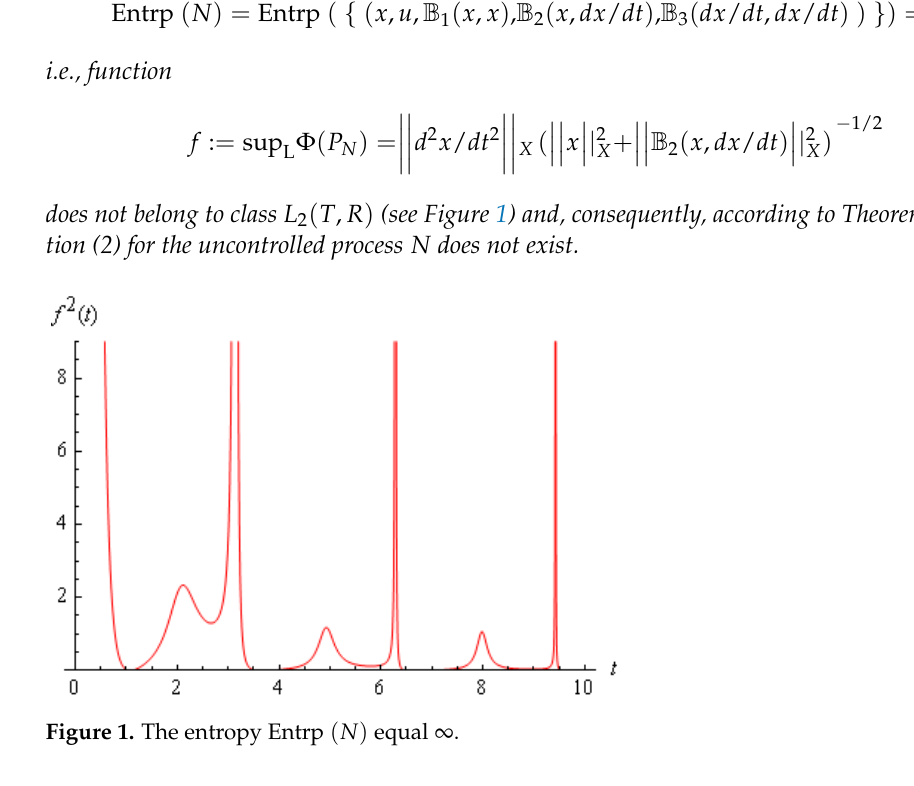
Figure 1. The entropy Entrp( ) N equal ∞ .